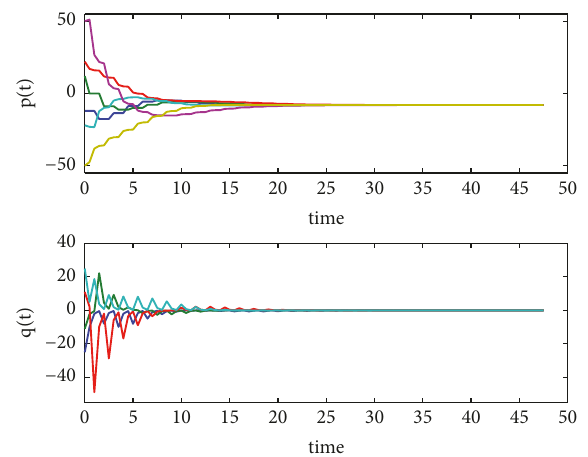
Figure 5: Agents’ state trajectories over networks switching among G G G 3 , 4 , and 5 .